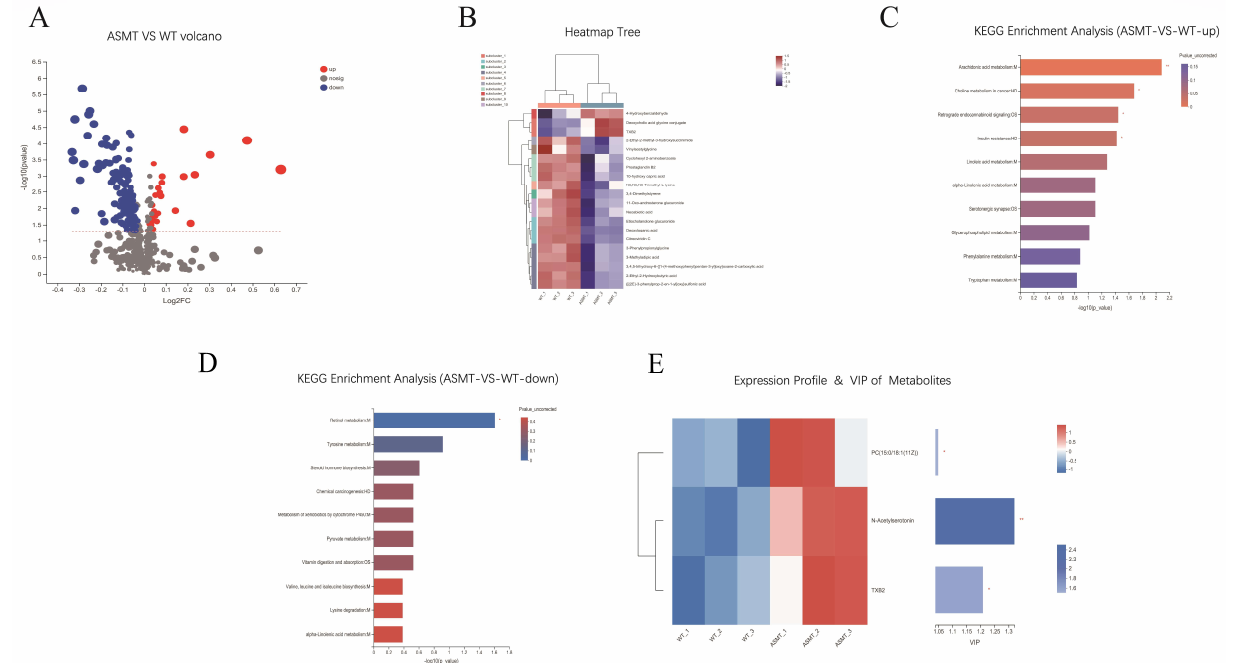
Figure 8. PLS-DA Metabolic analysis of transgenic (ASMT) and WT goats. ( A ) Volcanic map of differ- ential metabolites; ( B ) clustering heat map of differential metabolites; ( C ) KEGG functional analysis of cationic; ( D ) KEGG function analysis of anion; ( E ) VIP analysis diagram of differential metabolites. Note: the transgenic goat ( n = 3), wild type ( n = 3). * represents p < 0.05, ** represents p <